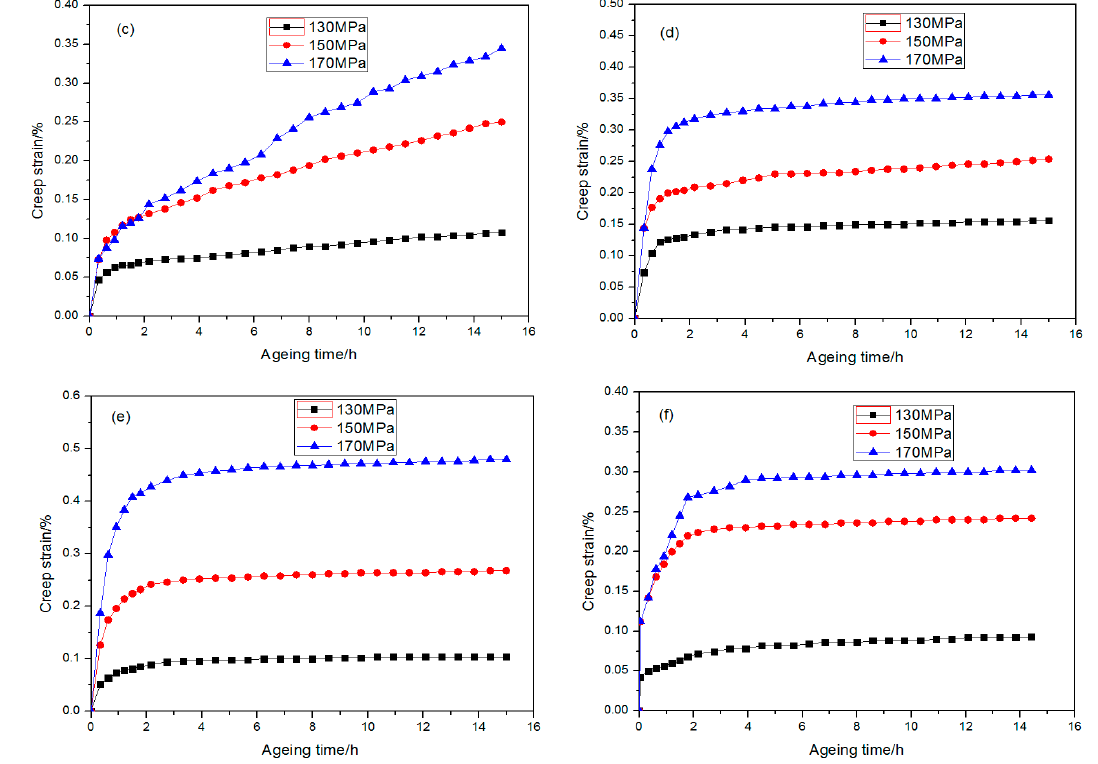
Figure 3. Creep curves of 2219 aluminum alloy at different temperatures and stress states. ( a ) 458 K; ( b ) 438 K; ( c ) 418 K; ( d ) 393 K; ( e ) 373 K; ( f ) 353 K.